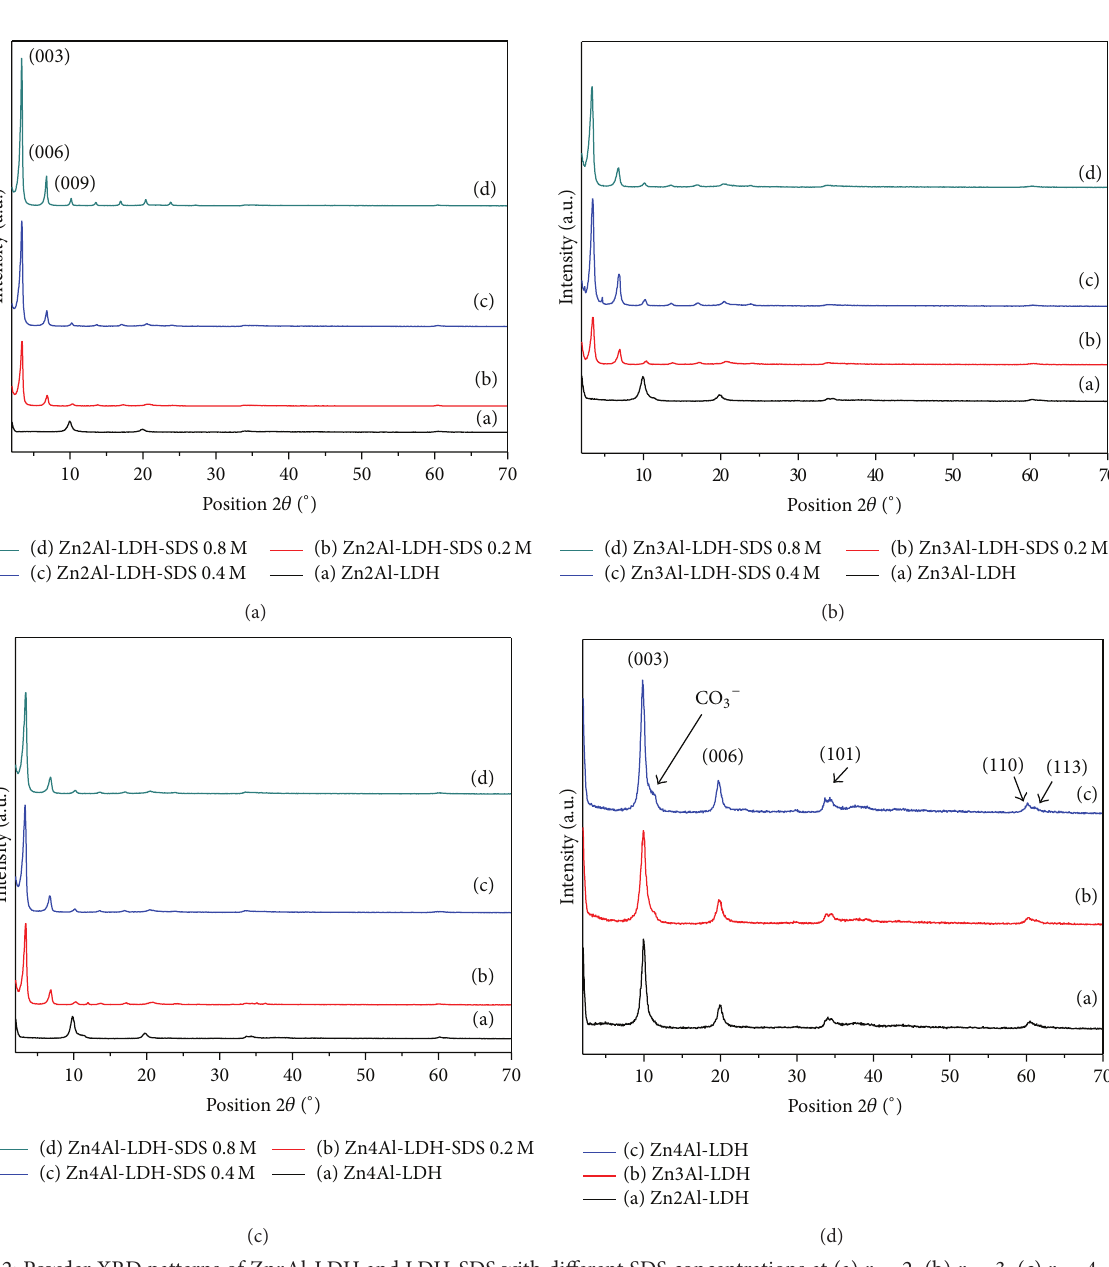
Figure 2: Powder XRD patterns of Zn 𝑟 Al-LDH and LDH-SDS with different SDS concentrations at (a) 𝑟 = 2 , (b) 𝑟 = 3 , (c) 𝑟 = 4 , and (d) Zn/Al-LDH at ratios 2, 3, and